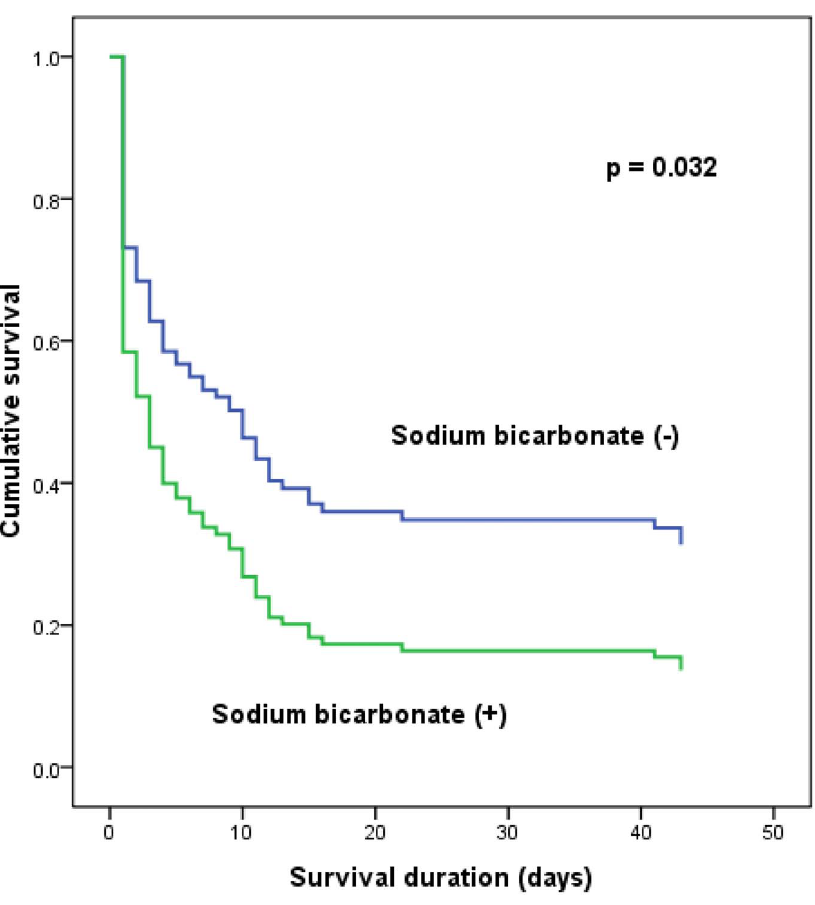
Figure 3. Cumulative survival curves for mortality according to sodium bicarbonate administration.